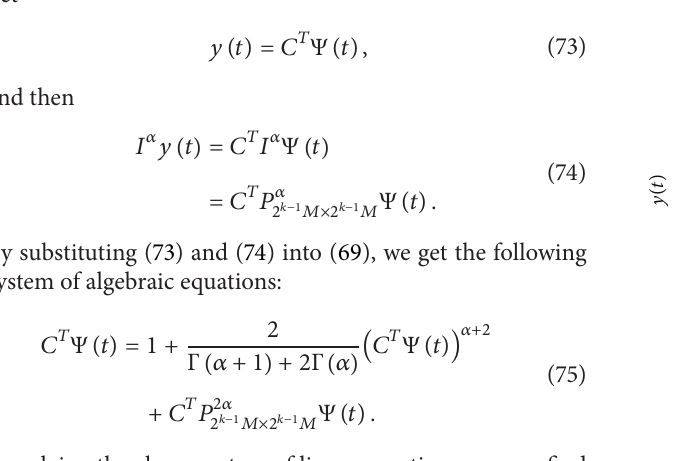
Figure 6: Numerical results of Example 3 by LWM for 𝛼 = 1